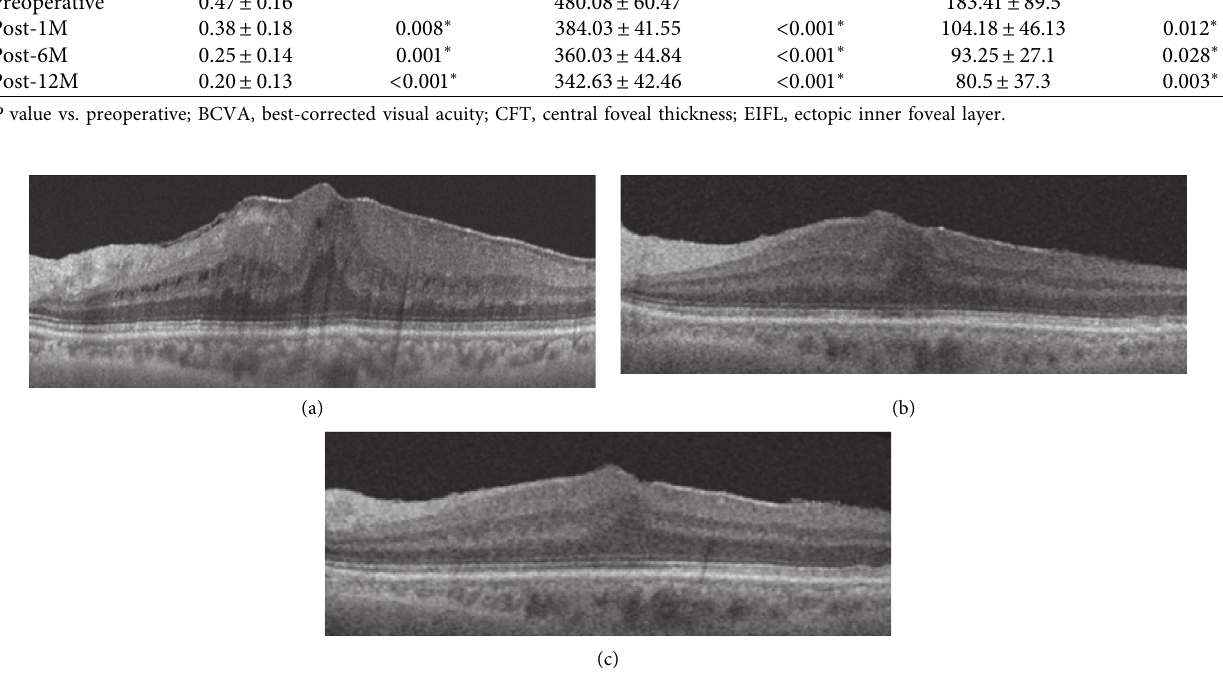
Figure 2: Optical coherence tomography images from a patient diagnosed with an epiretinal membrane (ERM). (a) Stage 3 ERM was diagnosed based on swept-source optical coherence tomography findings: the central fovea contains continuous ectopic inner foveal layers (EIFLs). (b) At 1 month after surgery, a thick EIFL persists over the outer nuclear layer. (c) At 12 months after surgery, the EIFL persists, although significant thinning has occurred. Visual acuity changed from 0.39 logMAR to 0.1 logMAR at 12 months after ERM surgery.